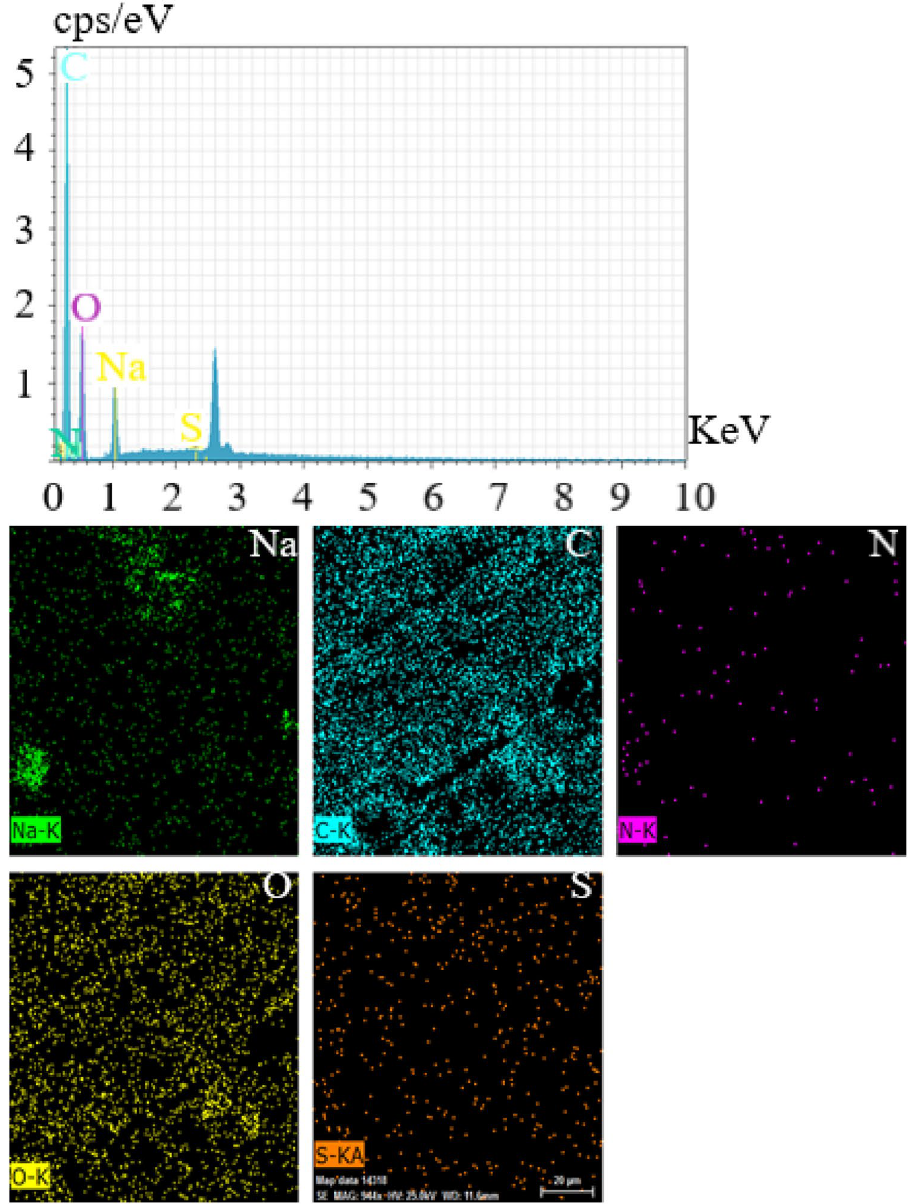
Figure 4. EDX and elemental mapping of